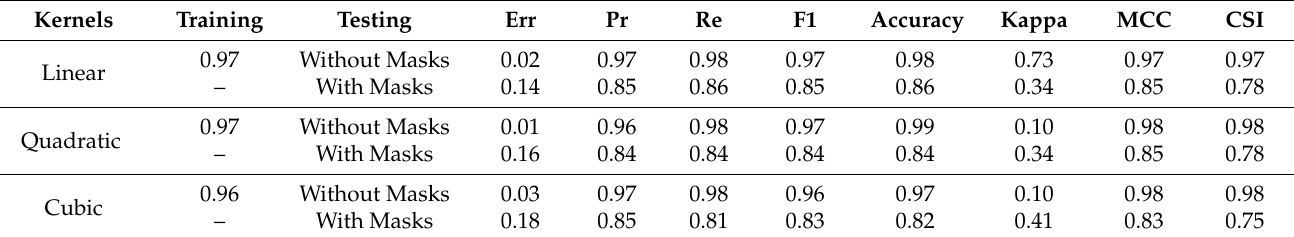
Table 5. Verification results of support vector machines.